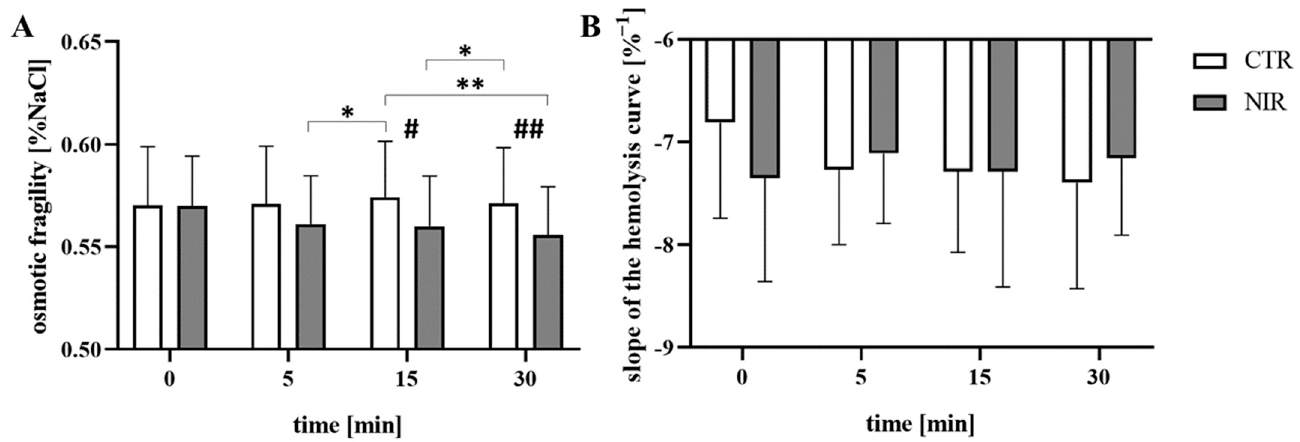
Figure 3. Changes in the osmotic fragility of RBCs ( A ) and the slope of the hemolysis curve ( B ) during in vitro HD. Pairs of variables that differed statistically from each other at the same time were denoted on the graphs with # p < 0.05, ## p < 0.01, while asterisks were used to mark other significantly different variables, * p < 0.05; ** p < 0.01. Results are presented as mean and SD. The number of independent experiments n = 13 for both